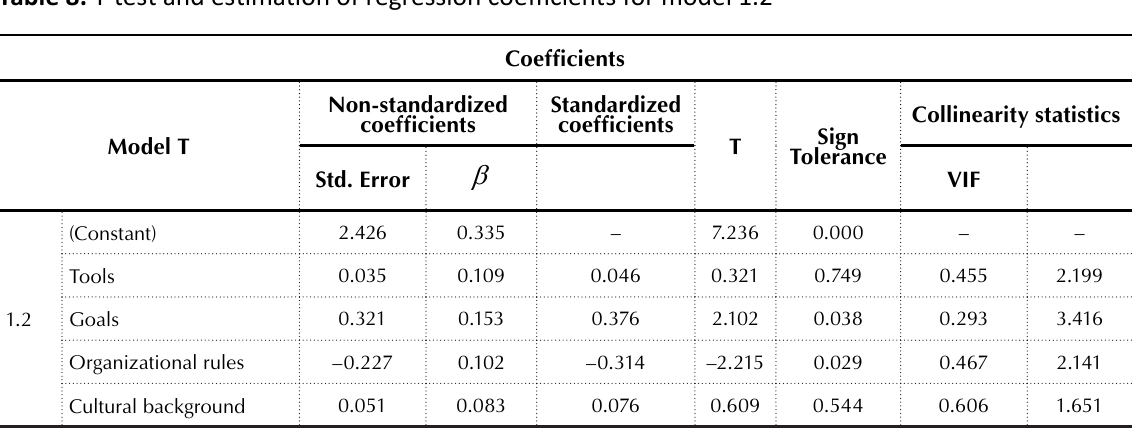
Table 8. T-test and estimation of regression coefficients for model